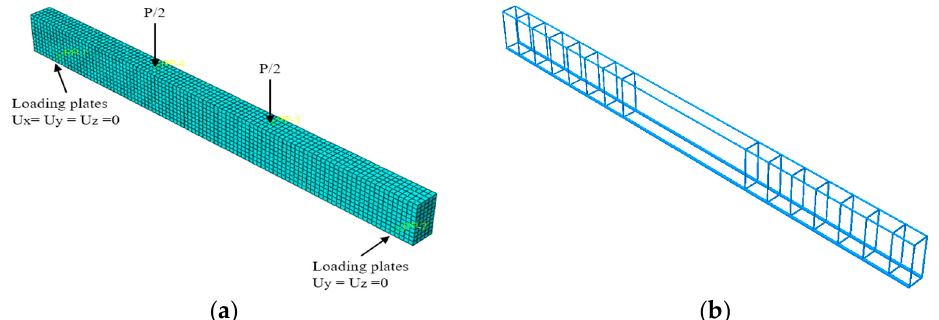
Figure 3. The FEA model. ( a ) Concrete and boundary consideration, ( b ) rebar cage.